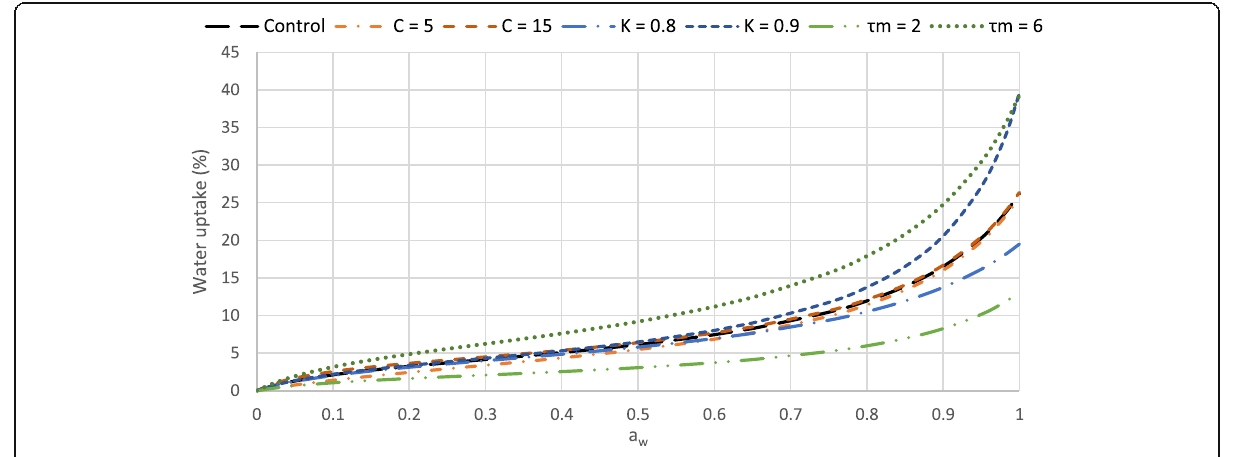
Fig. 3 Effect of GAB variables on the water adsorption